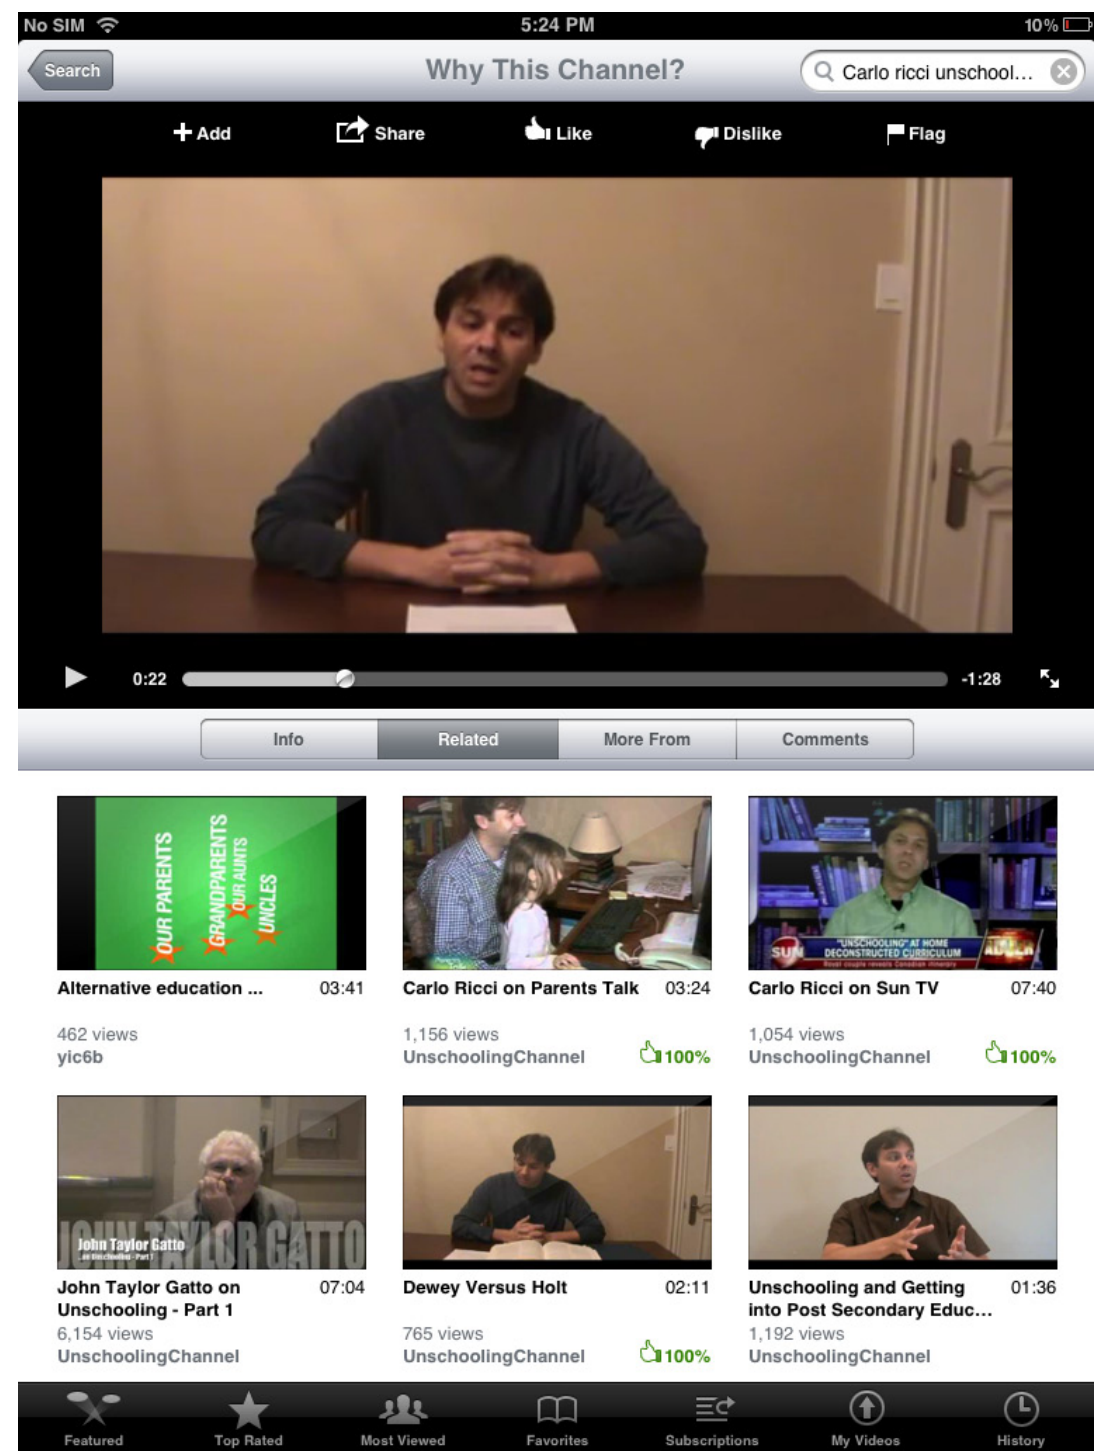
Figure 5 . YouTube